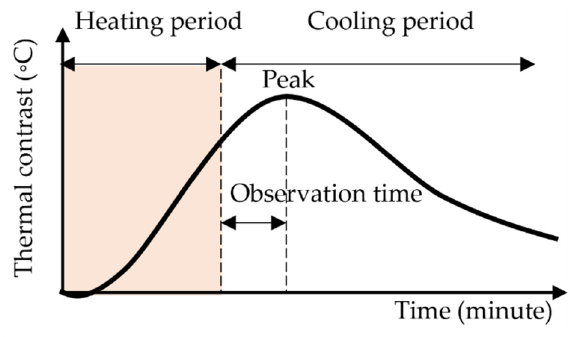
Figure 5. Typical thermal contrast transition in a laboratory test.